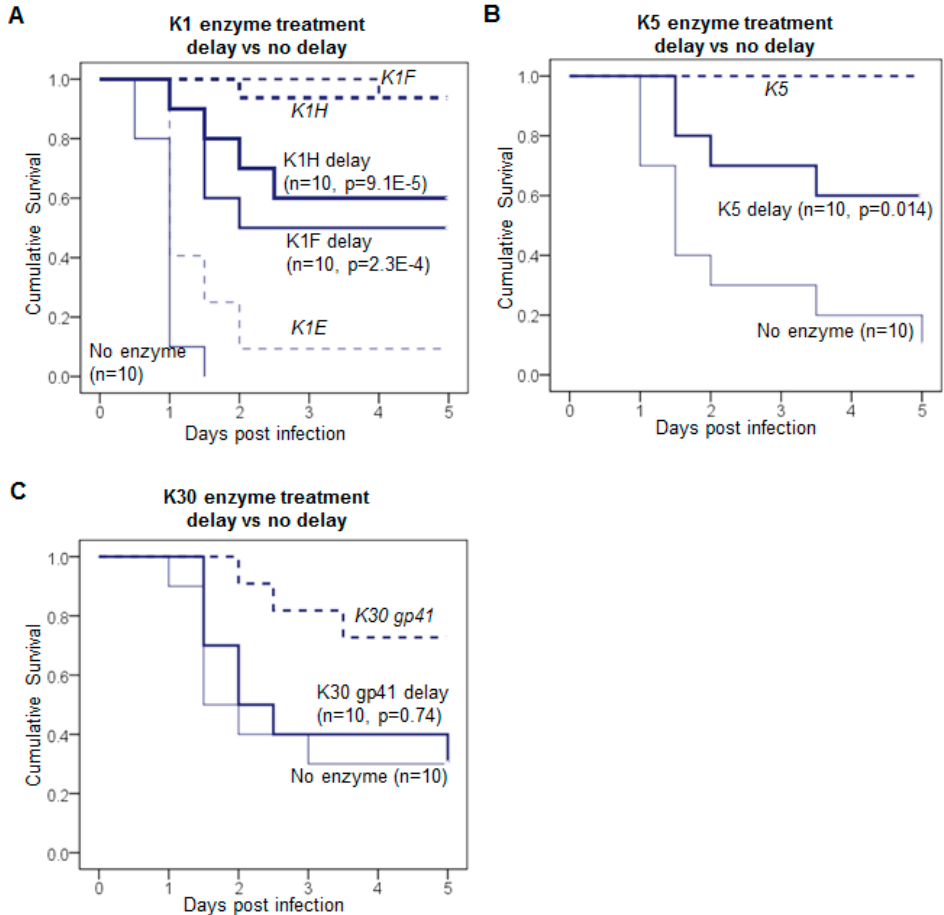
Figure 1. Delayed treatment of infection using capsule depolymerases. ( A ) 1.2–3.4 × 10 8 CFU of